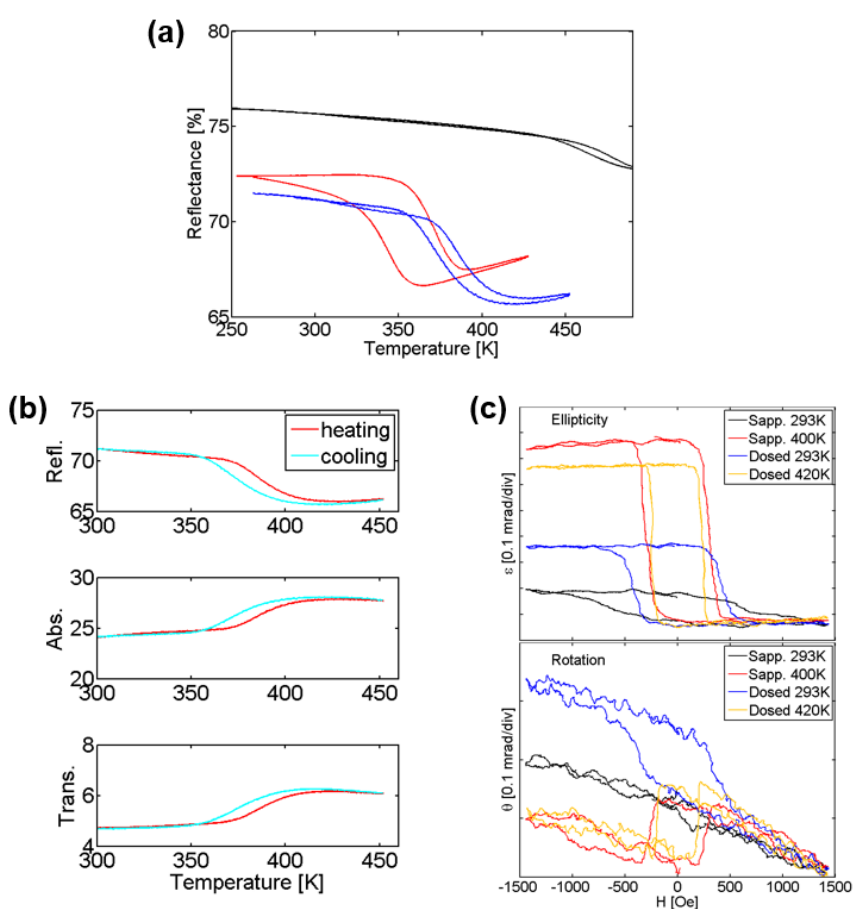
Figure 3. Optical properties of FeRh films. ( a ) reflectance at 1550 nm wavelength of FeRh films on MgO (black) and Al 2 O 3 (red) substrates and N-dose FeRh on MgO (blue). ( b ) optical reflectance, transmittance, and absorptance (calculated) of N-dosed FeRh films on MgO substrate at 1550-nm wavelength. ( c ) MOKE ellipticity (top) and rotation (bottom) of FeRh/Al 2 O 3 at 293 K and 400 K and dosed FeRh/MgO at 293 K and 420 K. For the FeRh/Al 2 O 3 the presence of a small MOKE signal at room temperature is due to the thermal hysteresis which does not recover, as seen in ( a ), until the sample is brought below 270 K.